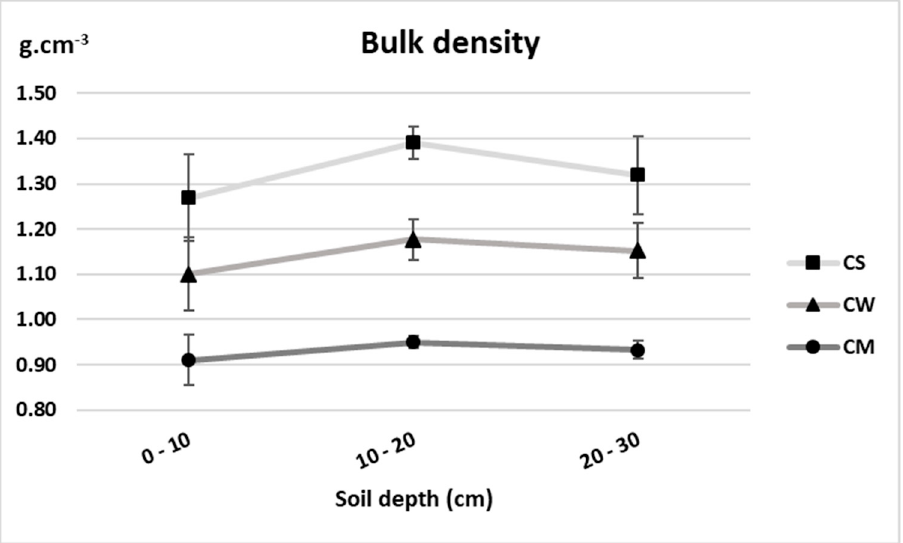
Figure 2. Bulk density (g.cm − 3 ) of unplanted soil (CS), soil cultivated by wheat (CW) and soil cultivated by miscanthus (CM) at depths (0–10, 10–20 and 20–30 cm). Values are presented as means ± SD. Different letters refer to significant differences in soils (Fisher LSD test, n = 4, p ≤ 0.05). As demonstrated in Figure 3, the lowest SOC concentrations were detected in the unplanted soils recording 21.68, 20.18 and 17.58 g.kg − 1 at 0–0, 10–20 and 20–30 cm depths respectively. The most significant increase was detected in the miscanthus cultivated soil at 0–10 cm depth (25.68 g.kg − 1 ), with a concentration 18.5% higher than its corresponding unplanted reference.